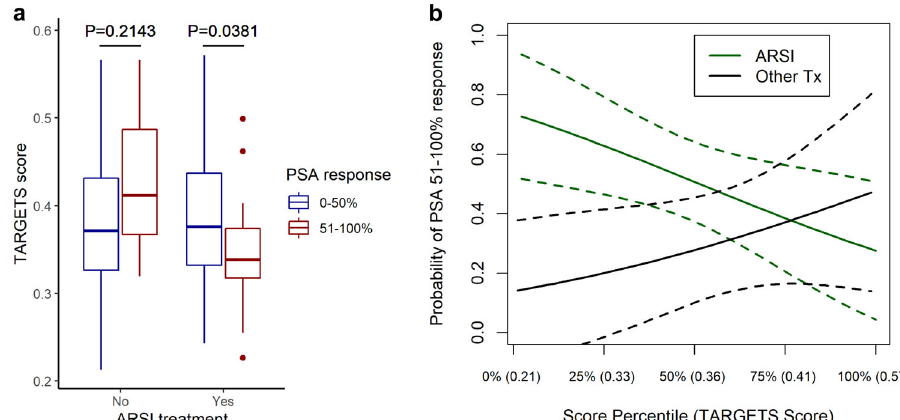
Fig. 4 Predicting response to ARSIs in mCRPC. a Patients receiving ARSIs who had a 51 – 100% response in PSA were predicted to be more sensitive by TARGETS than those with a 0 – 50% response. There was no difference in predicted sensitivity in those not treated. b Interaction plot showing the probability of PSA 51 – 100% response as a function of TARGETS score in the patients treated with an ARSI vs. other treatments. A lower TARGETS score indicates predicted sensitivity. Boxplot center line = median; box limits = upper and lower quartiles; whiskers = 1.5× interquartile range.